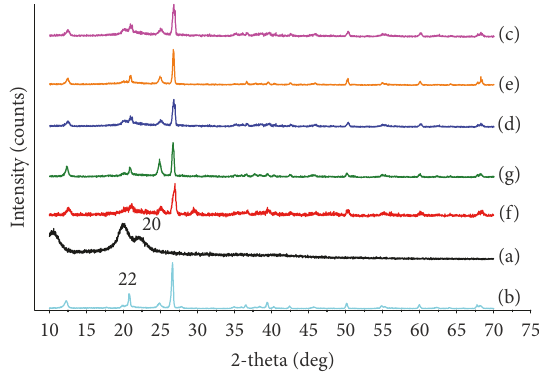
Figure 5: XRD of CHT-MC composites ((a) CHT, (b) RC, (c) SB-1, (d) SB-2, (e) SB-4, (f) SB-3, and (g)